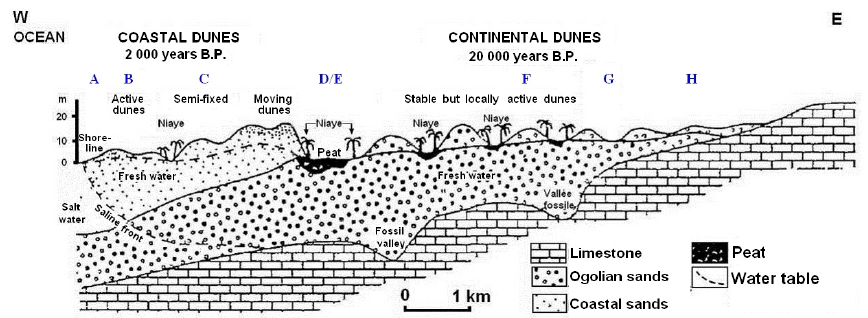
Figure 2. Geological section of the Niayes and location of agro ‐ ecological zones (adapted from Pezeril et al. [22]).